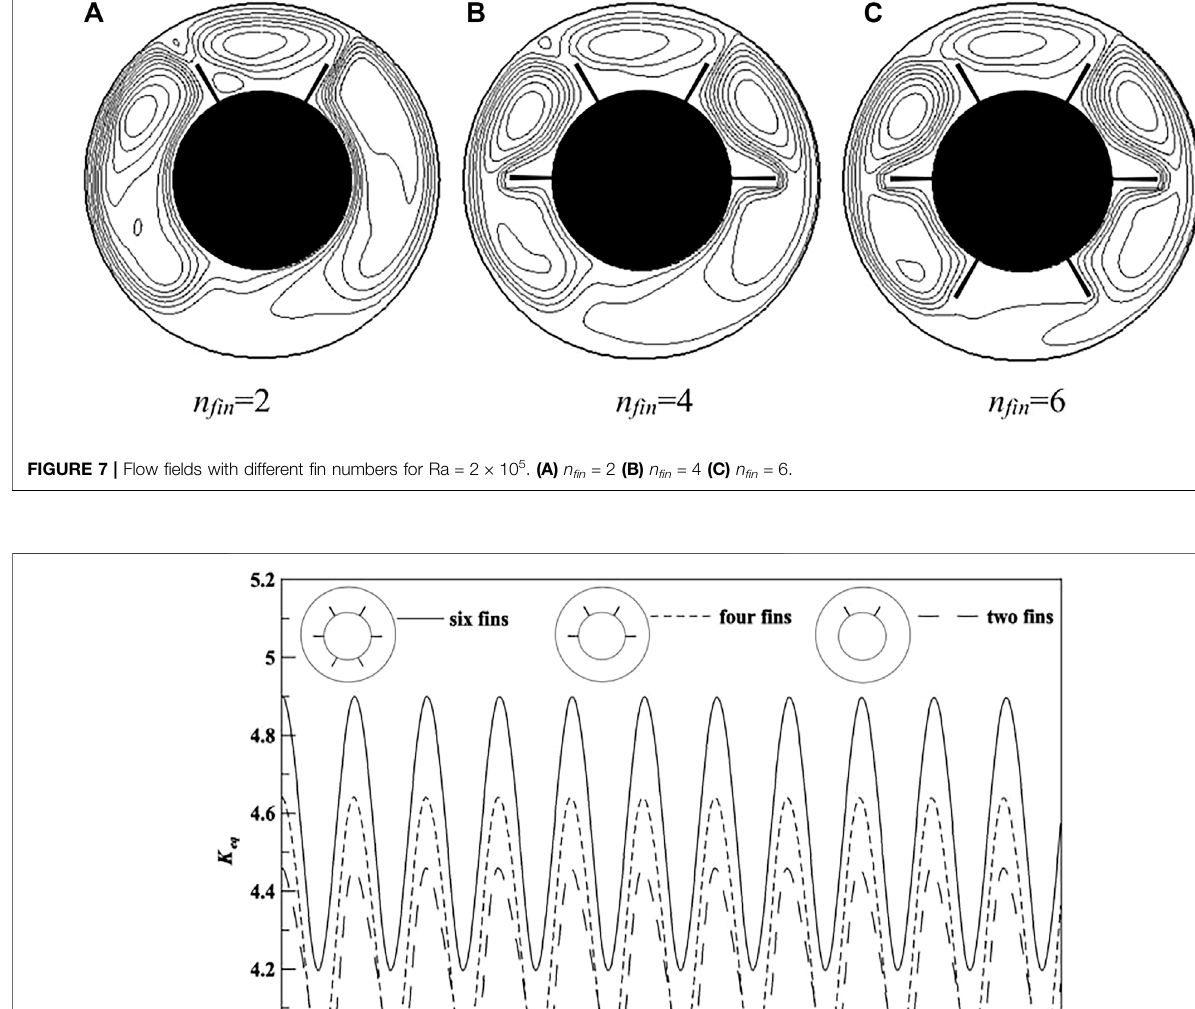
Frontiers in Energy Research |